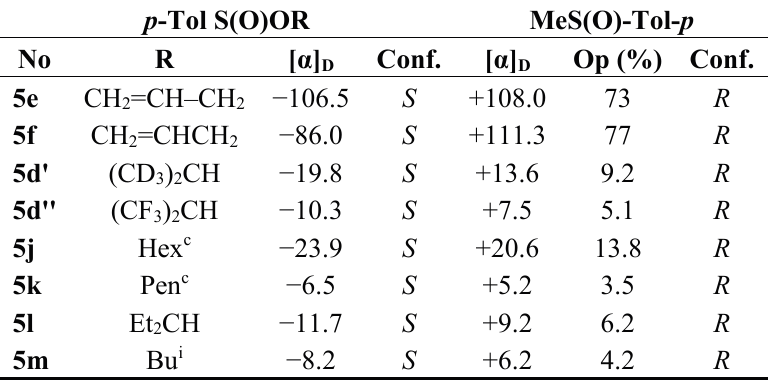
Table 12. Determination of optical purity of sulfinates ( − )-5 by their conversion into (+)-( R )-methyl p -tolyl sulfoxide. p -Tol S(O)OR MeS(O)-Tol- p No R [ α ] Conf. [ α ] Op (%) Conf. D D 5e CH =CH–CH − 106.5 S 2 2